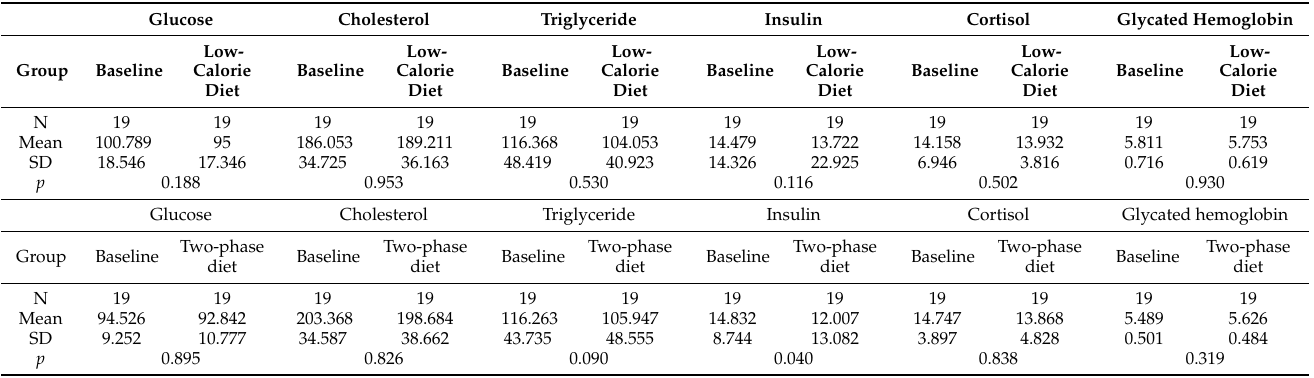
Table 2. Mean values of clinical measurements of the total number of participants (N) belonging to baseline, low-calorie diet, and two-phase diet groups. SD: Standard